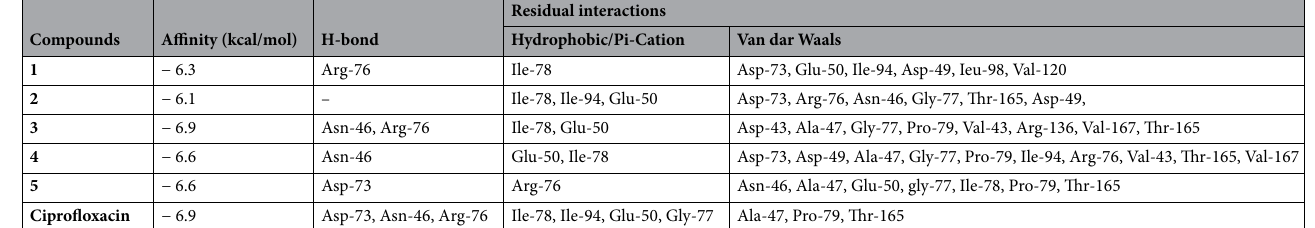
Table 6. Molecular docking value of compounds isolated from root extracts of O. cufodontii .